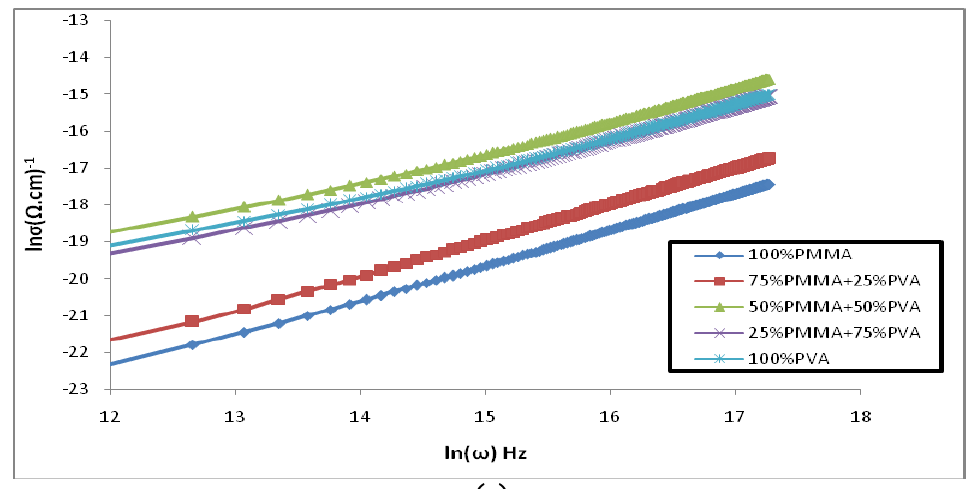
Fig. 3: Variation of ln(σ) with ln (ω) for PMMA/PVA blends (a)